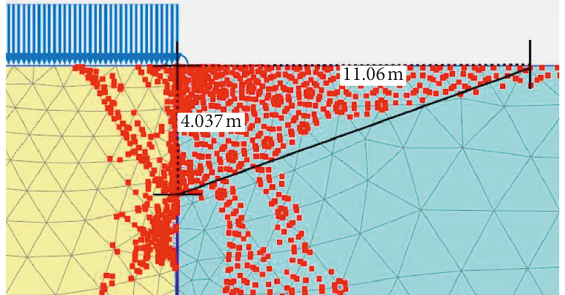
Figure 11: Distribution of failure points inside the foundation pit at φ � 15 ° .